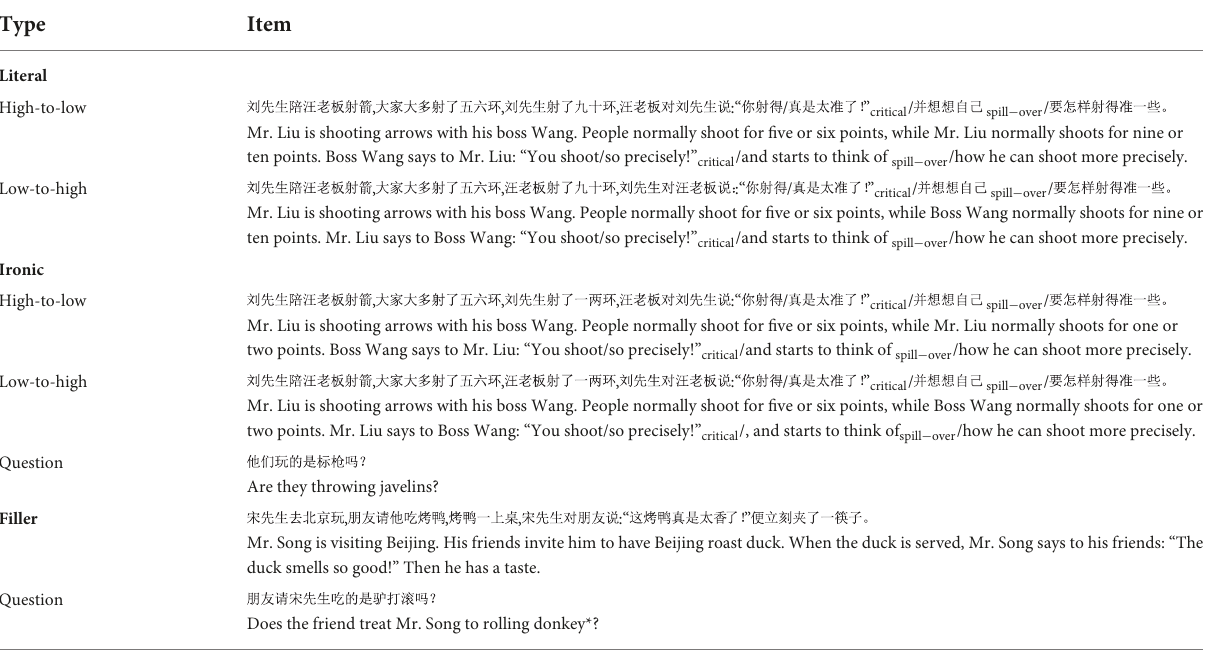
TABLE 1 Examples of test items in eye-tracking